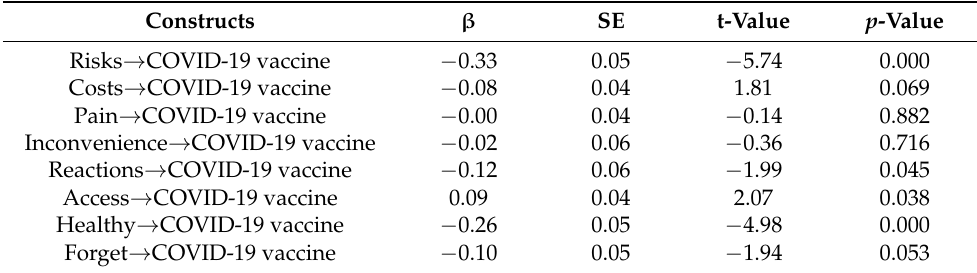
Table 8. Effects inference—anti-COVID-19 vaccine